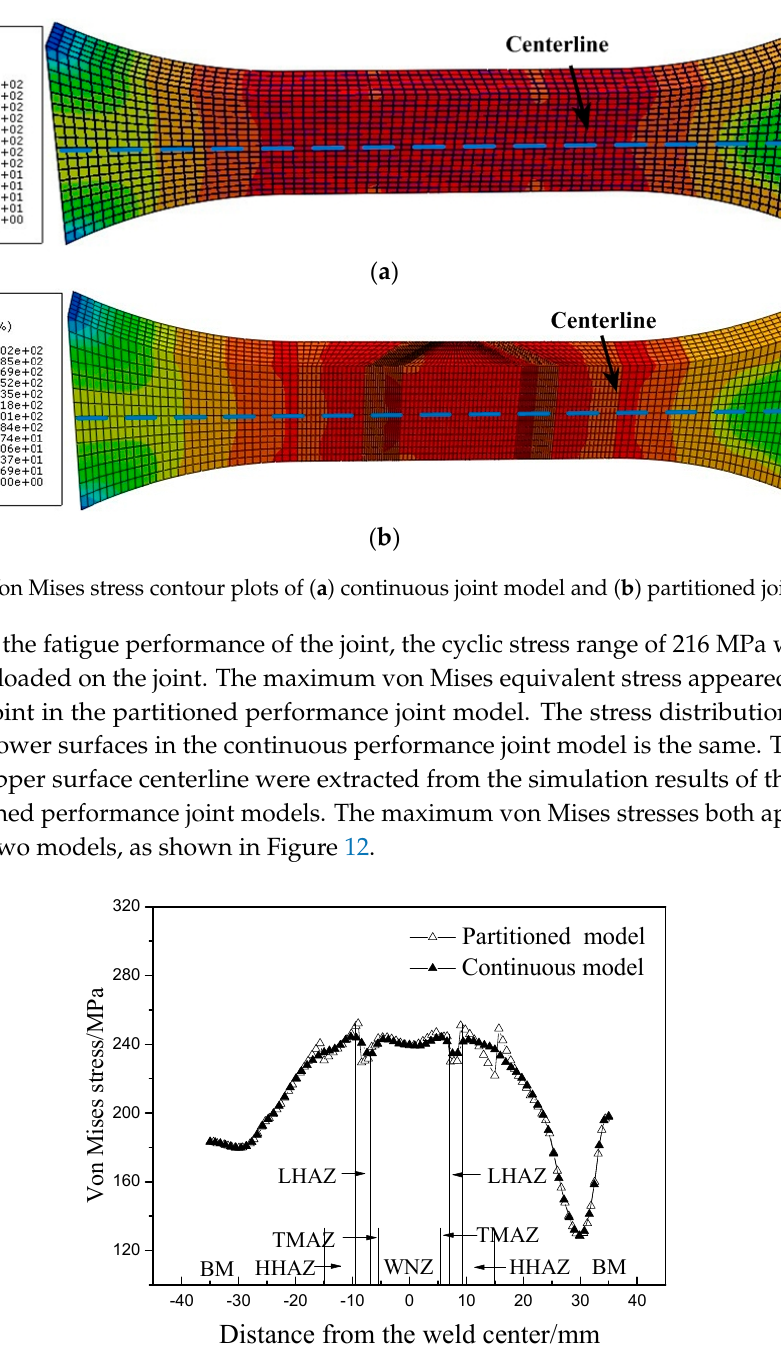
Figure 12. Von Mises stresses distributions of upper surface in the joint model.